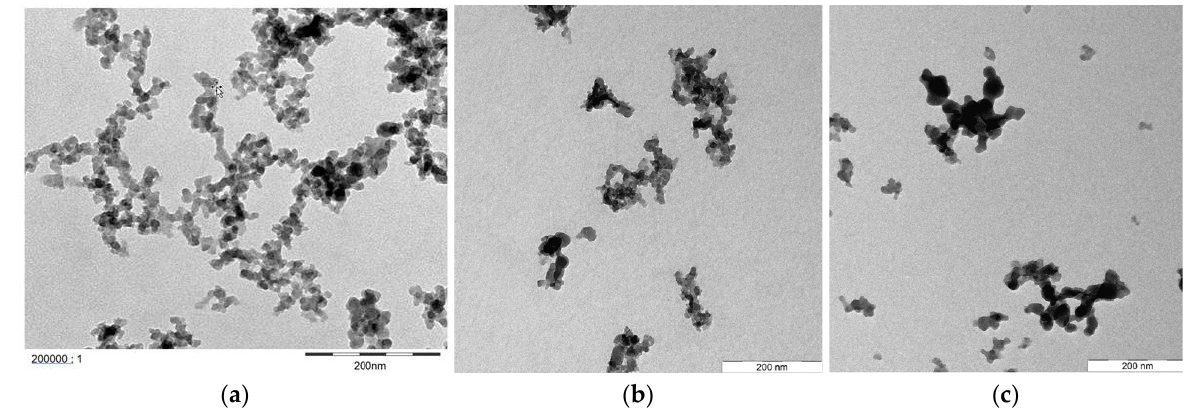
Figure 3. Transmission Electron Microscope (TEM) images measured for the nanomaterials used in this work. Unmodified silica nanomaterials shown in ( a ), Nanofluid A in ( b ) and Nanofluid B in ( c ).